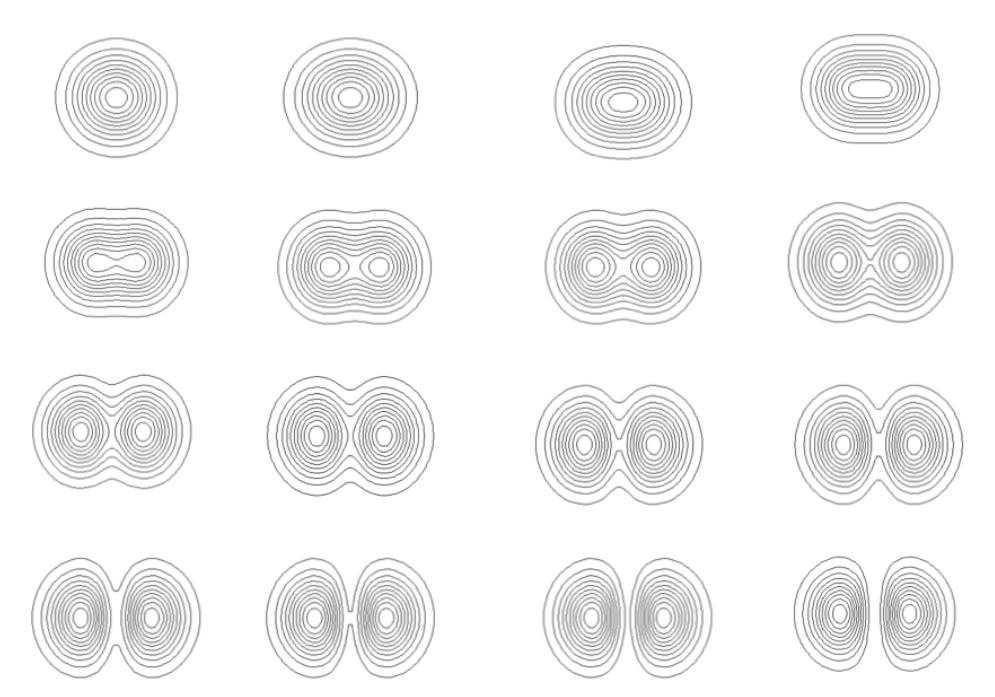
Figure 6. Steps of duplication. Stationary solutions of the Schr¨odinger equation can take only discretized morphologies in correspondence with quantized values of the energy. The successive figures (from top left to bottom right) give different steps of the division process, obtained as solutions of the time-dependent Sch¨odinger equation in an harmonic oscillator potential, which jump from the fundamental level (top left) to the first excited level (bottom right).